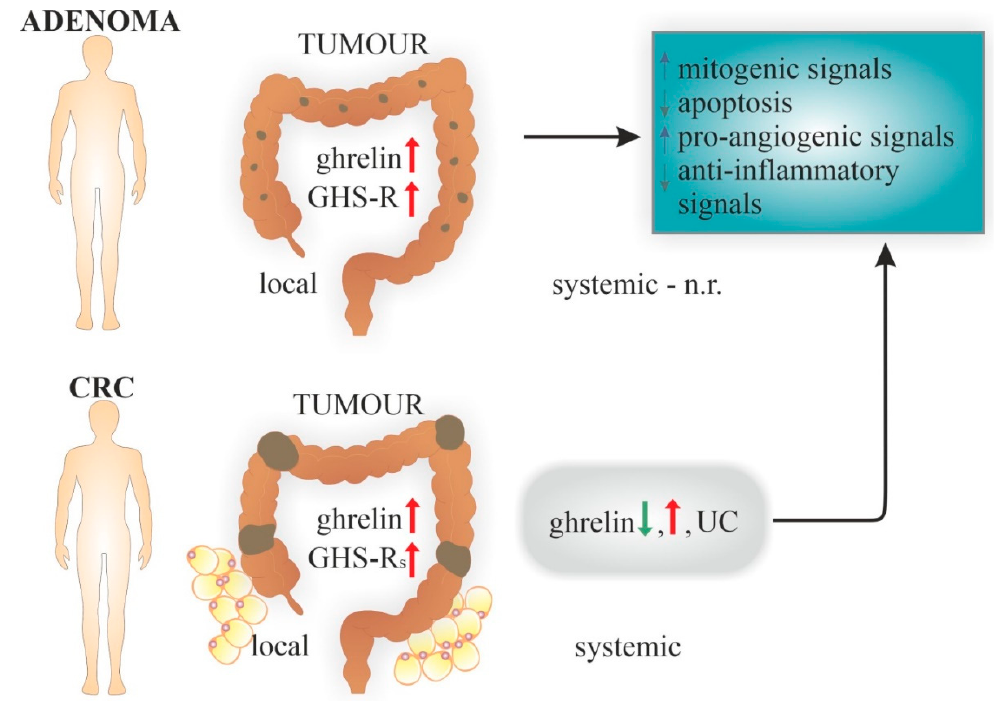
Figure 2. Potential role of both local expression and systemic levels of the ghrelin system in the pathogenesis of colorectal cancer (CRC). [ ↓ / ↑ -reduced/increased expression/level; AG-acylated ghrelin; GHS-R(s)-ghrelin receptor(s); UC-unchanged; n.r.-not